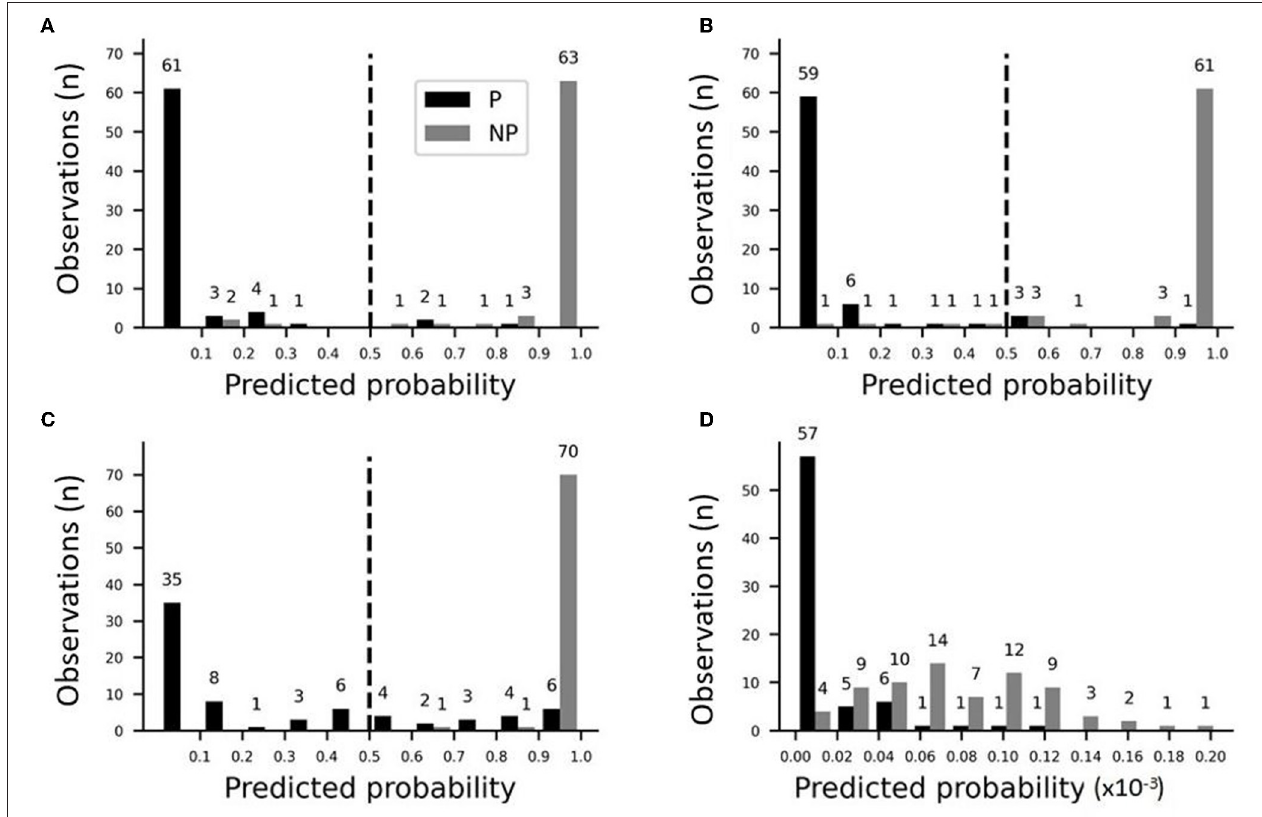
FIGURE 6 | Predicted probabilities of identifying axon types (P vs. NP) in stepwise logistic regression models by applying a threshold of 0.5. Distribution of predicted probabilities: (A) The final model with bouton-convergence and bouton density as the predictor variables; (B) A model with bouton-convergence as a single predictor variable; (C) Contribution of bouton-convergence in the final model; (D) Contribution of bouton density in the final